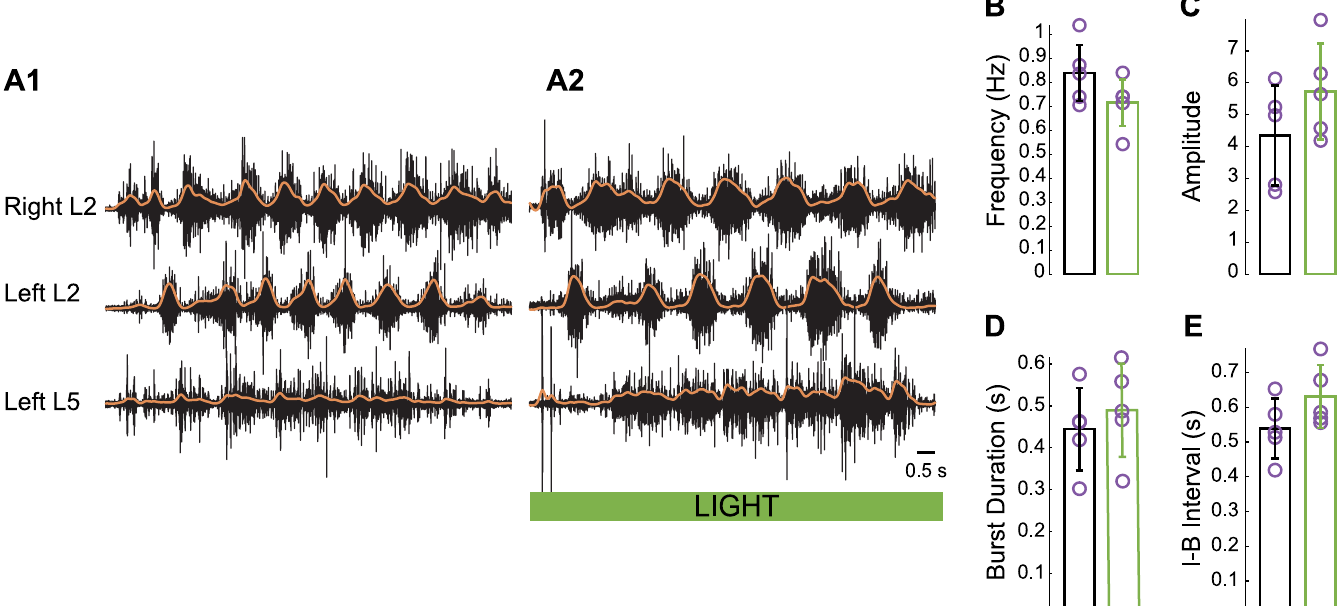
Fig 4. Hyperpolarization of V1 interneurons does not abrogate ventral root–evoked, locomotor-like activity. (A) Ventral root–evoked fictive locomotion before (A1) and during (A2) hyperpolarization of V1 interneurons. (B-E) Average frequency (B), amplitude (C), burst duration (D), and the I-B interval (E) of ventral root– evoked, locomotor-like activity measured in a flexor-related segment (L2) before and after hyperpolarization of V1 interneurons (Wilcoxon signed-rank test, n = 5, B: p = 0.125, C: p = 0.1875, D: p = 0.3125, E: p = 0.3125, respectively). The data underlying this figure can be found in S3 Data. I-B,